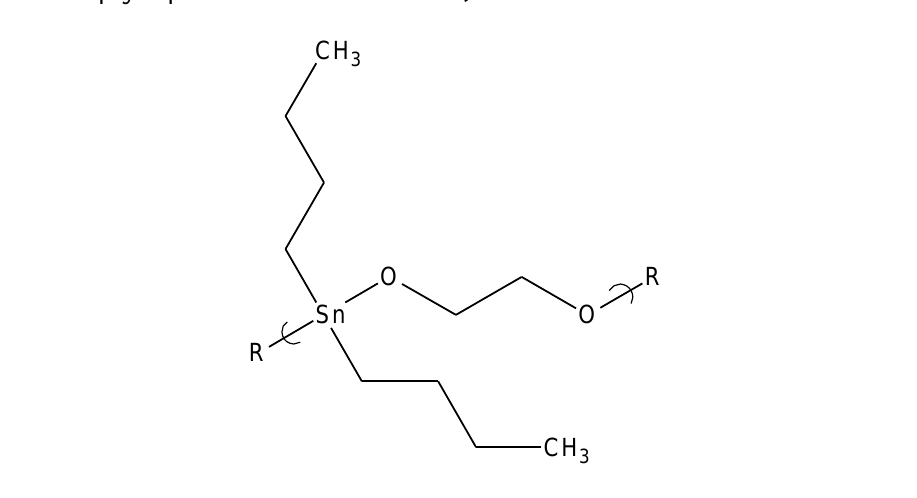
Figure 1. Repeat unit for the product from ethylene glycol and dibutyltin dichloride (In all cases, the R simply represents chain extension).